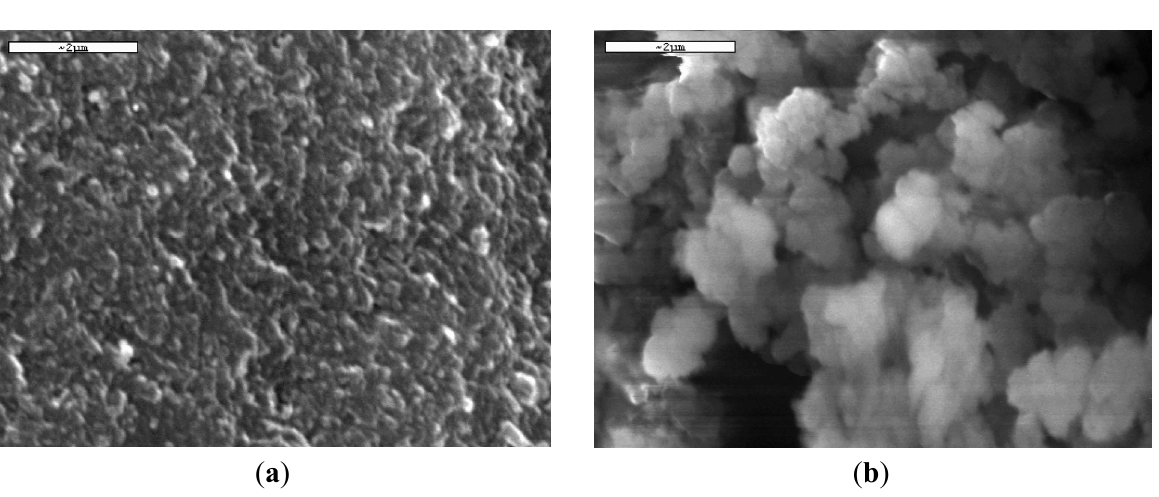
Figure 2. SEM micrographs of dye-MIPs using ( a ) aqueous and ( b ) organic solvent. Reproduced with permission from George Z. Kyzas [44], published by Elsevier,